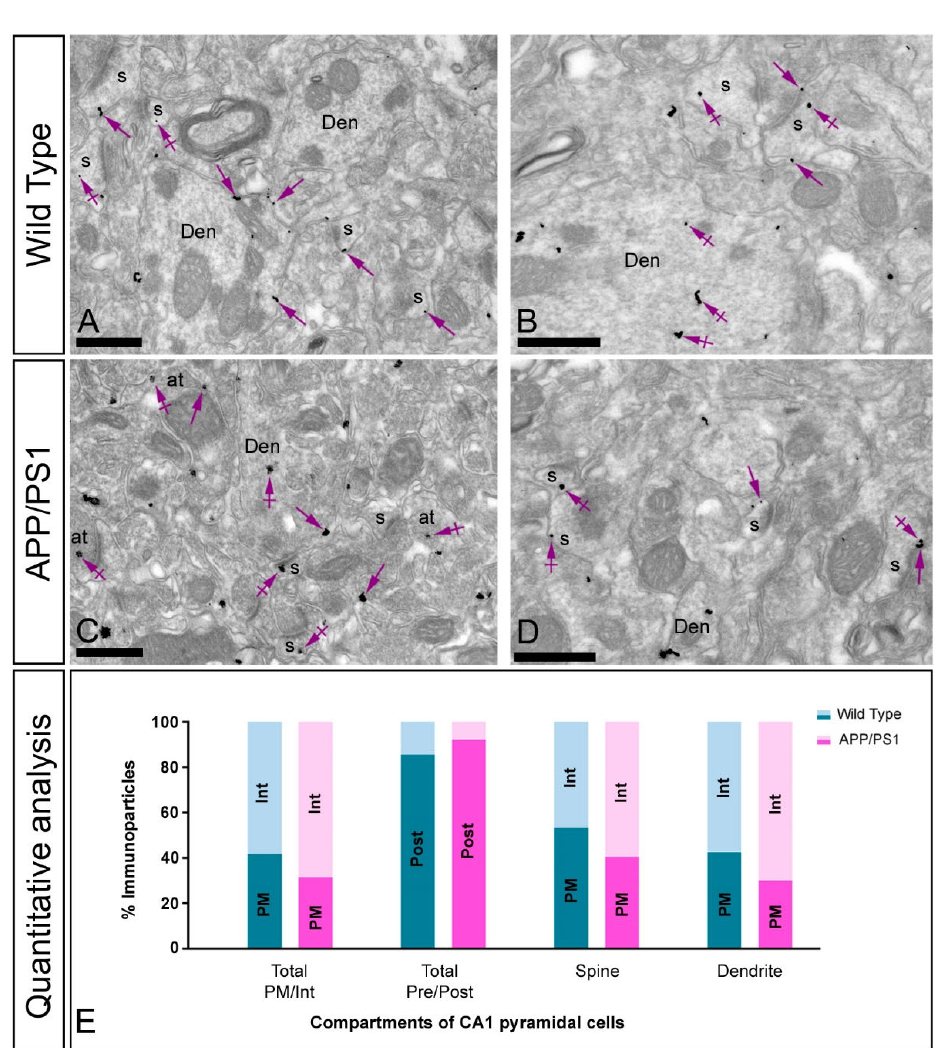
Figure 5. Changes in the postsynaptic localisation of GIRK2 in the hippocampus of APP/PS1 mice. Electron micrographs showing immunoparticles for GIRK2 in the stratum radiatum of the CA1 region at 12 months of age in wild type and APP/PS1 mice, as detected using a pre-embedding immunogold technique. ( A – D ) In wild type mice, GIRK2 immunoparticles were mostly located along the extrasynaptic plasma membrane (arrows) of dendritic spines (s) and shafts (Den) of CA1 pyramidal cells, and at intracellular sites (crossed arrows). In APP/PS1 mice, GIRK2 immunoparticles were less frequently observed along the extrasynaptic membrane (arrows) of dendritic spines (s) and shafts (Den), but more frequently detected at intracellular sites (crossed arrows). ( E ) Quantitative analysis of immunoparticles for GIRK2 in different compartments of CA1 pyramidal cells demonstrated the reduction of labelling along the extrasynaptic plasma membrane and the increase at intracellular sites in APP/PS1 mice. Scale bars: ( A – D ): 500 nm.